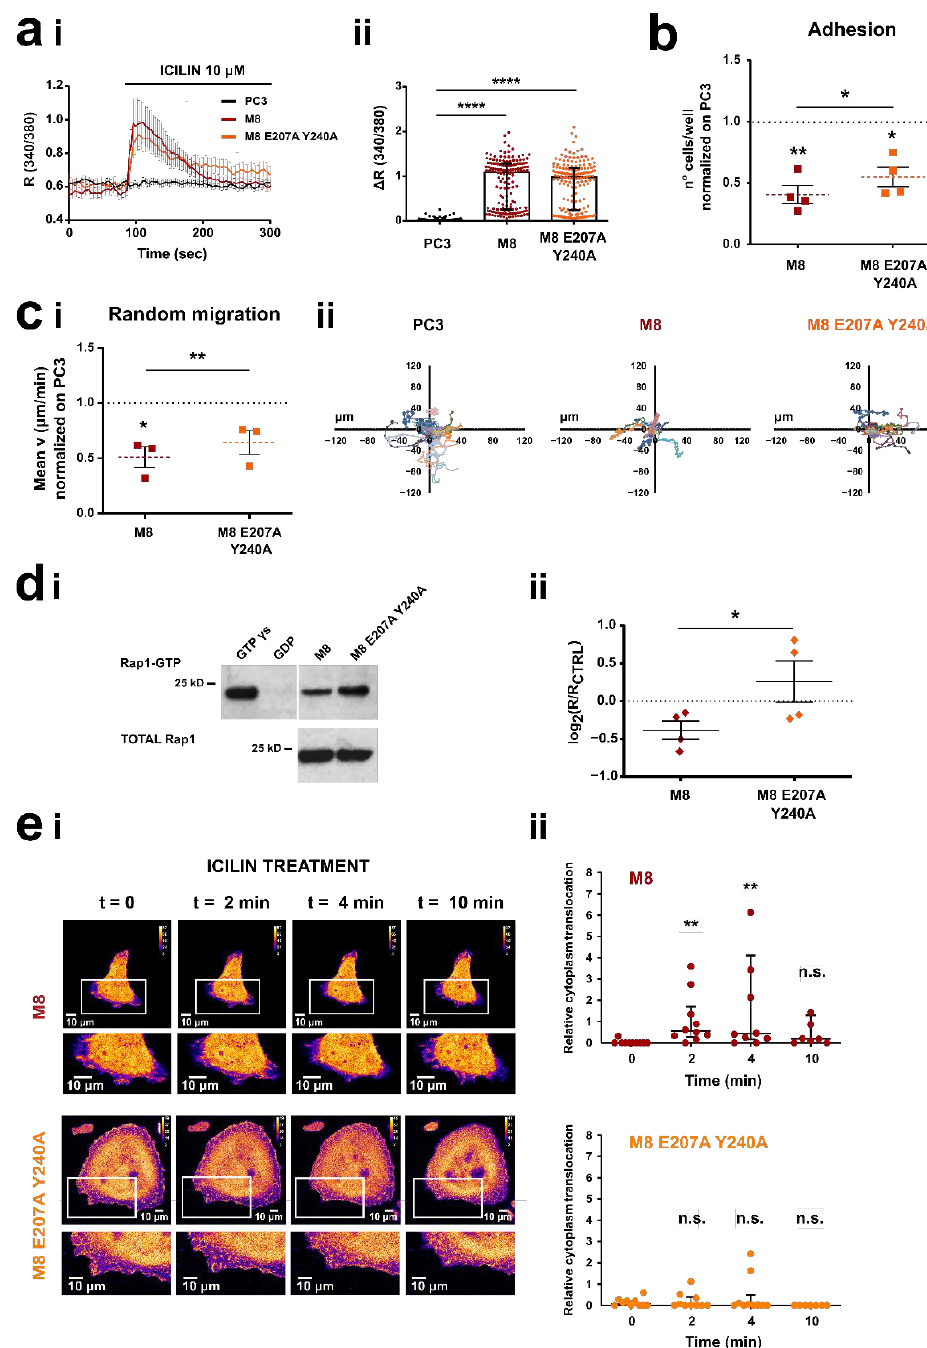
Figure 7. TRPM8 mutant’s functional validation. ( ai ) Ca 2+ -imaging traces in response to TRPM8 agonist (10 µ M icilin) in PC3 (control in black), PC3 transiently overexpressing TRPM8 (red) and PC3 transiently overexpressing TRPM8 E207A Y240A mutant (orange). Traces represent the mean ± SEM of cells in the recorded field of one representative experiment ( n = 45 for PC3, n = 32 for M8 and n = 33 for M8 E207A Y240A). ( aii ) Scatter dot plot showing peak amplitude of icilin-mediated Ca 2+ responses (median with interquartile range of different cells in the field from at least 7 independent experiments). Only icilin-responsive cells were considered to compare TRPM8 and TRPM8 E207A Y240A channel activity ( n = 228 for PC3, n = 160 for M8 and n = 167 for M8 E207A Y240A). Statistical significance versus PC3, ****: p < 0.0001 (Kruskal–Wallis test with Dunn’s post-hoc test). ( b ) Quantification of adhesion assays on PC3 overexpressing TRPM8 wt (red) or TRPM8 E207A Y240A (orange) and